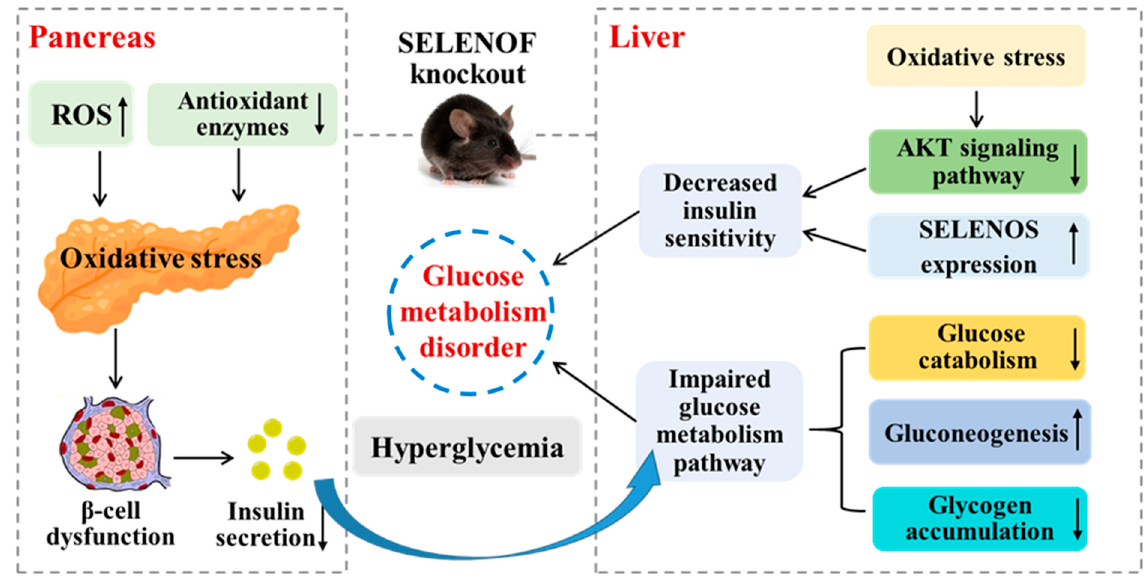
Figure 9. Schematic diagram of glucose metabolism disorders caused by SELENOF KO in young mice and the related mechanism. SELENOF KO could reduce insulin secretion in the pancreas of young mice resulting in impaired glucose metabolism pathways including decreased glucose catabolism and glycogen accumulation as well as increased gluconeogenesis in the liver. SELENOF KO could also reduce insulin sensitivity by inhibiting the AKT signaling pathway and upregulating SELENOS expression in the liver. The redox homeostasis disruption induced by SELENOF KO in the liver and pancreas contributed to glucose metabolism disorders in young mice directly or indirectly.